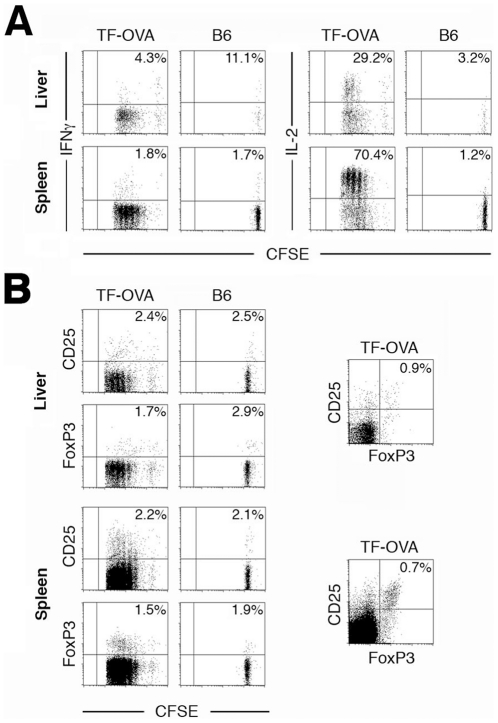
CD4 T-cells primed by liver-derived antigen display deficient Th1-effector function.(A) Four million CFSE-labeled OT-II T-cells were transferred intravenously into TF-OVA mice or into B6 control mice. After 68 hours, non-parenchymal cells were purified from liver and spleen and incubated in vitro with PMA/ionomycin. Production of Interferon-γ and IL-2 was analyzed after 4 hours. Representative results are depicted (n = 6). (B) Mice were treated as in (A), but cells were analyzed for CD25 and FoxP3 expression immediately after purification of cells from the indicated organs. Representative results are depicted from n = 6 mice in each group. All plots depict data gated on CD4+CFSE+ cells. CD25/FoxP3 plots on the right depict the frequency of CD25+FoxP3+ double positive cells.